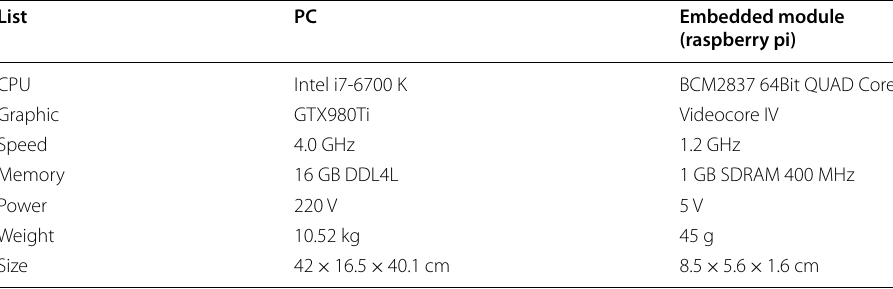
Table 7 Comparison of performance of PC and embedded module List